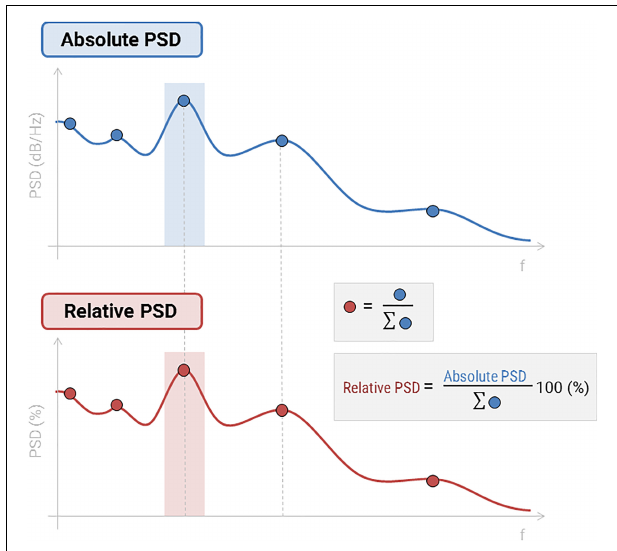
FIGURE 3 | Absolute and relative PSD. Relative PSD values range between 0 and 1, indicating the contribution of the current frequency band to the total power in the